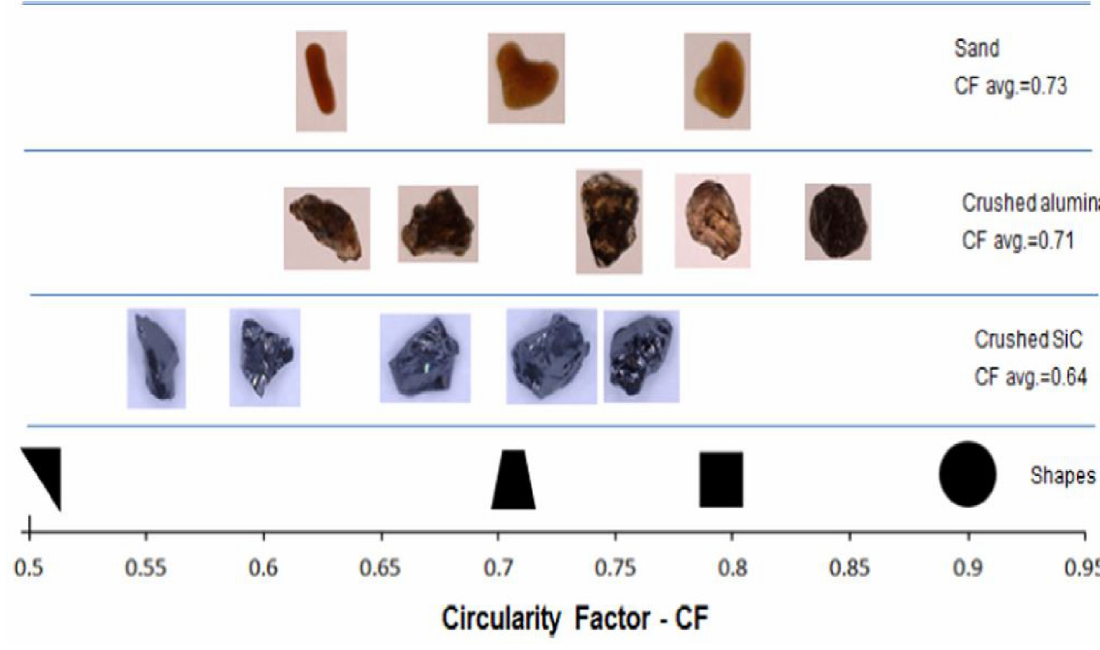
Figure 17. Representation of particle shapes before testing